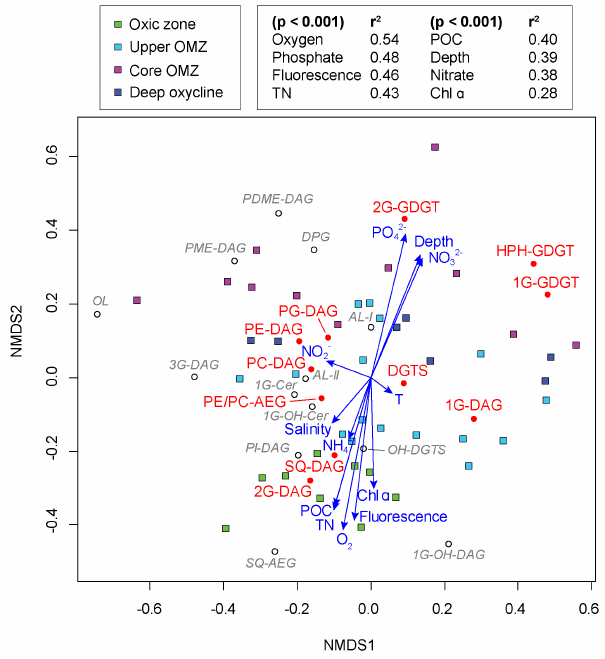
Figure 6. Nonmetric multidimensional scaling (NMDS) ordination plot assessing the relationship between IPL biomarkers, sampling depths and geochemical parameters in the ETNP (stress of 0.125). Squares represent the water depth of each sample and are color- coded according to the defined geochemical zonation. Filled circles stand for the lipid distribution of major IPLs and open circles for minor IPLs on the ordination. Vector lines of geochemical parame- ters are weighted by their p values with each NMDS